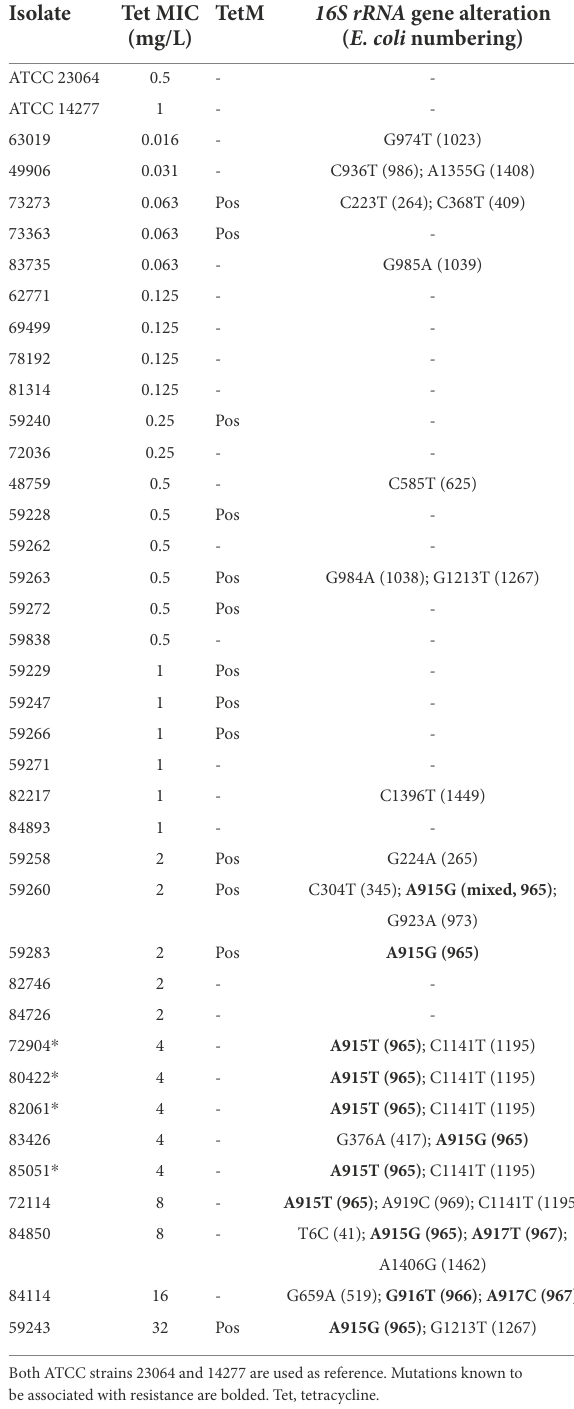
TABLE 4 Tetracycline MIC and genetic